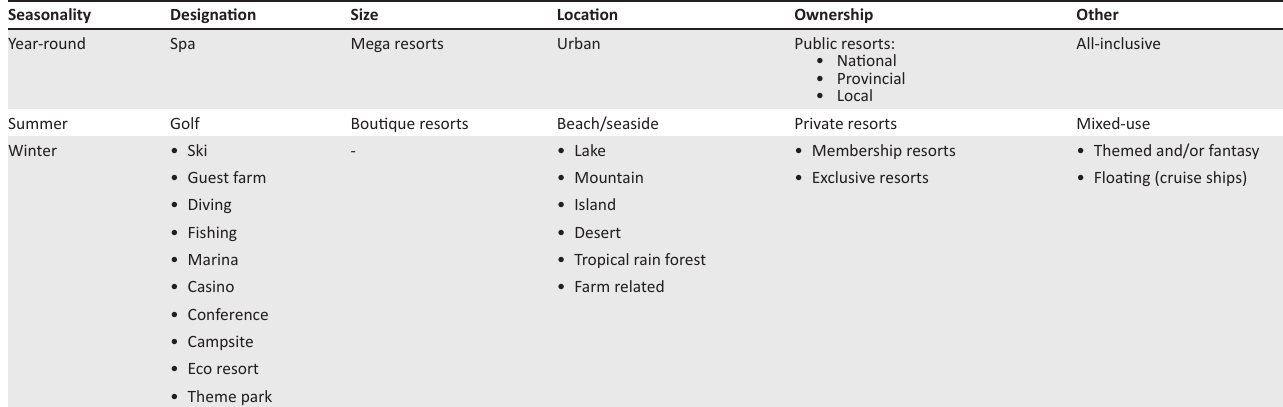
TABLE 1: Types of resorts.